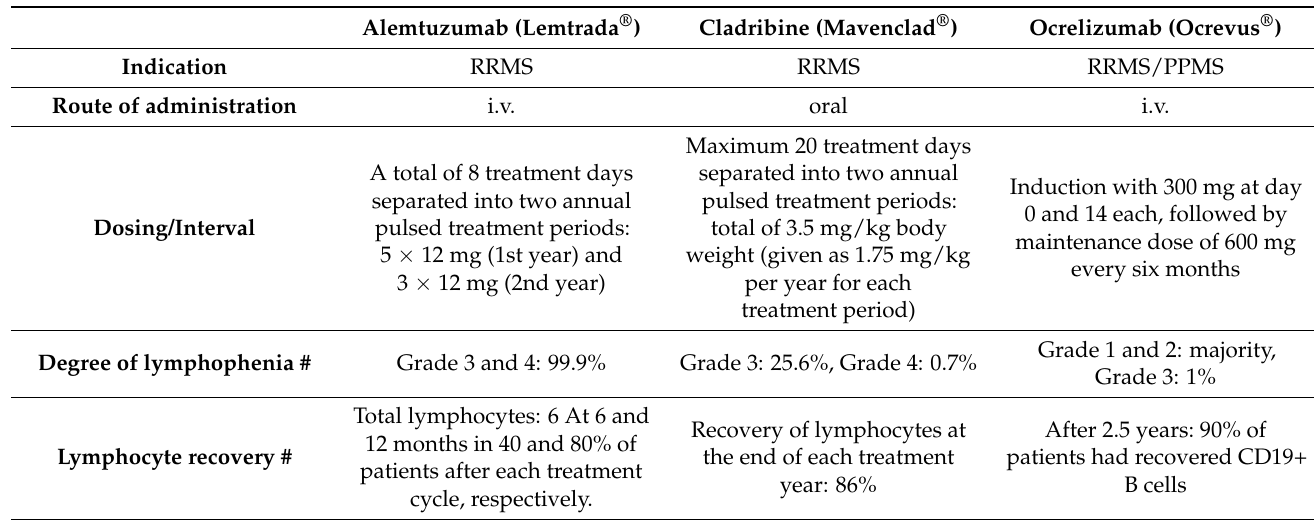
Figure 1. Principles of maintenance/escalation therapy ( A ) and immune-depleting therapy ( B ). Typical representatives of maintenance therapies are interferon-β formulations, glatiramer acetate, S1P-receptor modulators, natalizumab and teriflunomide. Immune-depleting therapies approved for the treatment of MS are alemtuzumab, cladribine and ocrelizumab. The key features of use and depletion are summarized in Table 1. Table 1. Overview of pulsed immunodepleting therapies approved for the treatment of MS and their extent of lymphopenia, adapted from [7] .